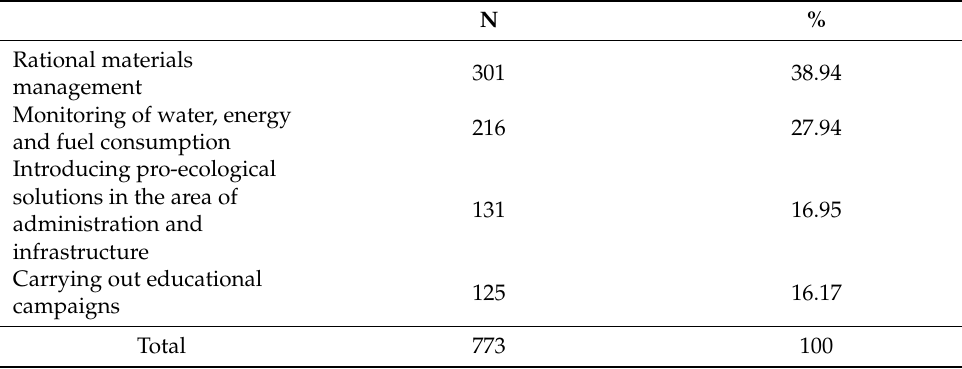
Table 4. Actions taken to protect the